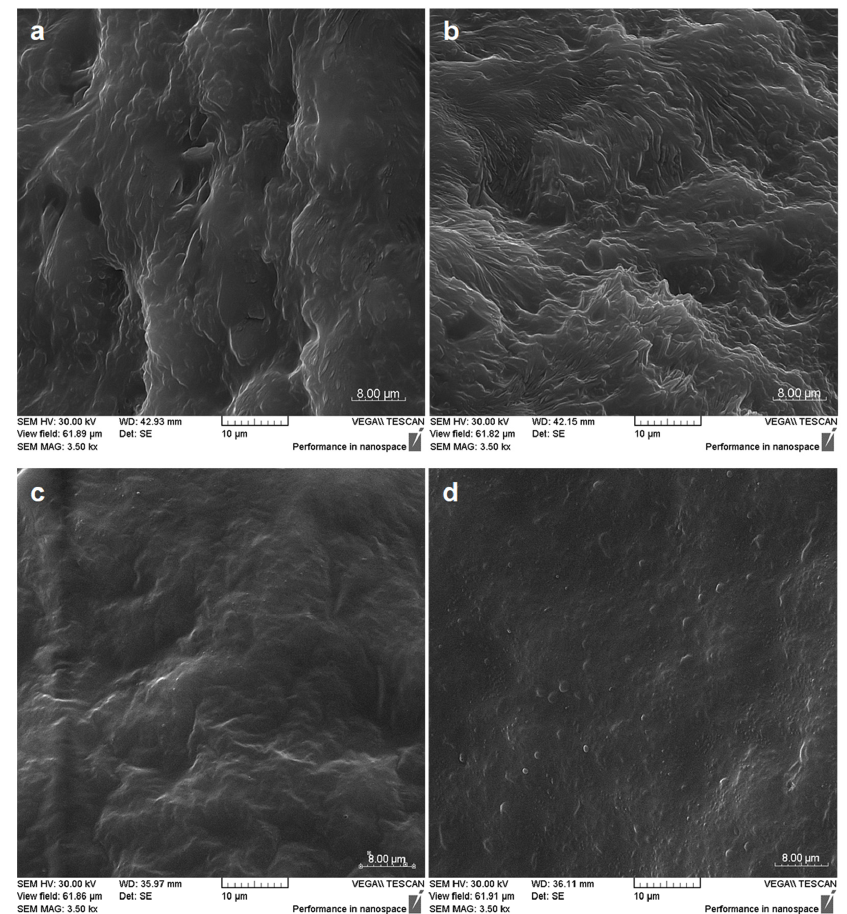
Figure 4. Scanning electron microscopy (SEM) of yoghurts, magnification 3500×. Microstructure: ( a ) the plain, natural yoghurt during 0 day of storage in the refrigerated conditions; ( b ) the plain, natural yoghurt during 21 days of storage in the refrigerated conditions; ( c ) the yoghurt with sea buckthorn mousse during 0 day of storage in the refrigerated condi- tions; ( d ) the yoghurt with sea buckthorn mousse during 21 days of storage in the refrigerated conditions.